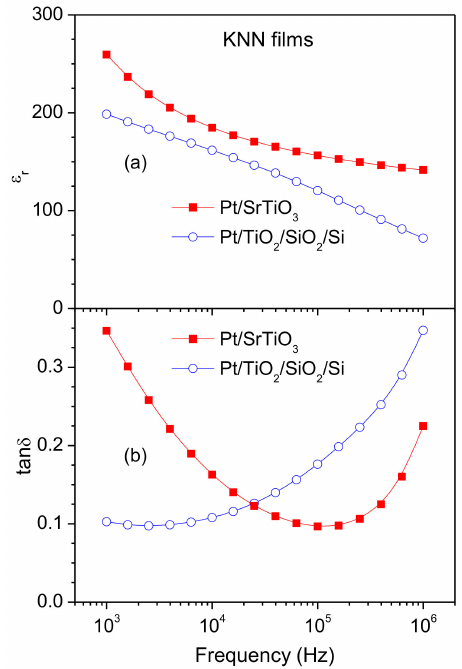
Figure 1. Frequency dependence of the relative dielectric permittivity ε r ( a ) and dissipation factor tan δ ( b ) of K 0.5 Na 0.5 NbO 3 (KNN) films on Pt/TiO 2 /SiO 2 /Si (open circles) and Pt/SrTiO 3 substrates (solid squares) at room